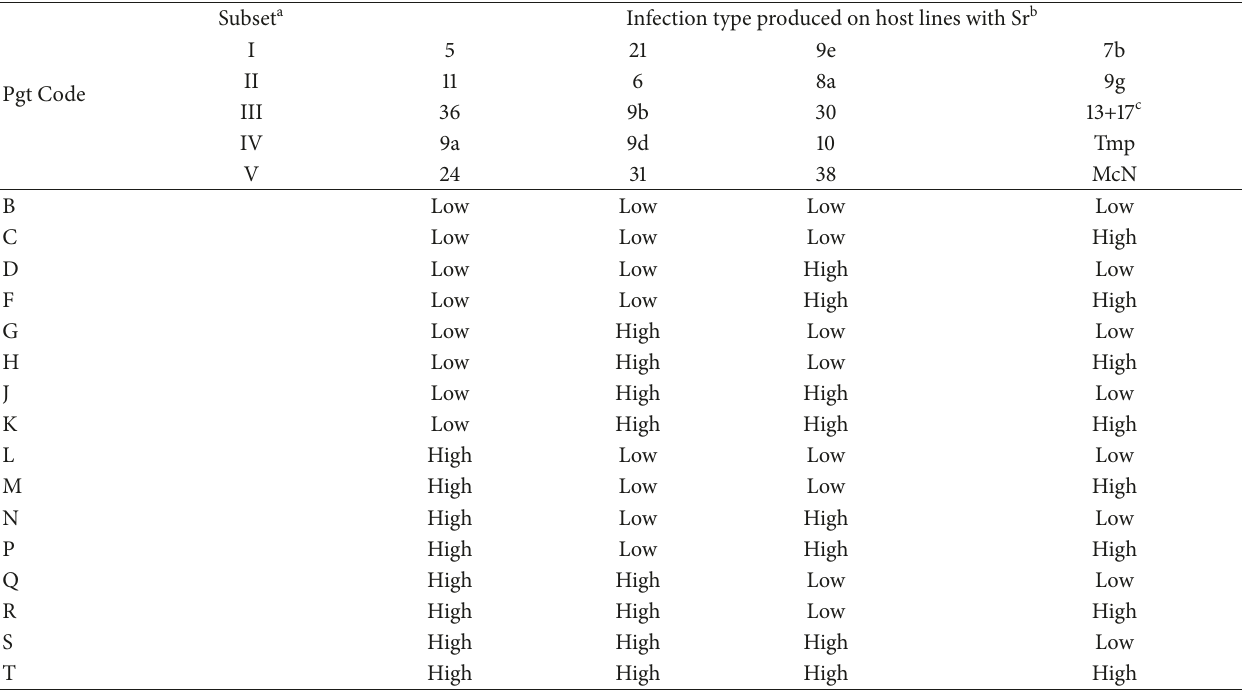
Table 2: The race nomenclature mechanisms (Pgt -code) for the 20 wheat stem rust differential hosts for Puccinia graminis f. sp. tritici in order of subsets of